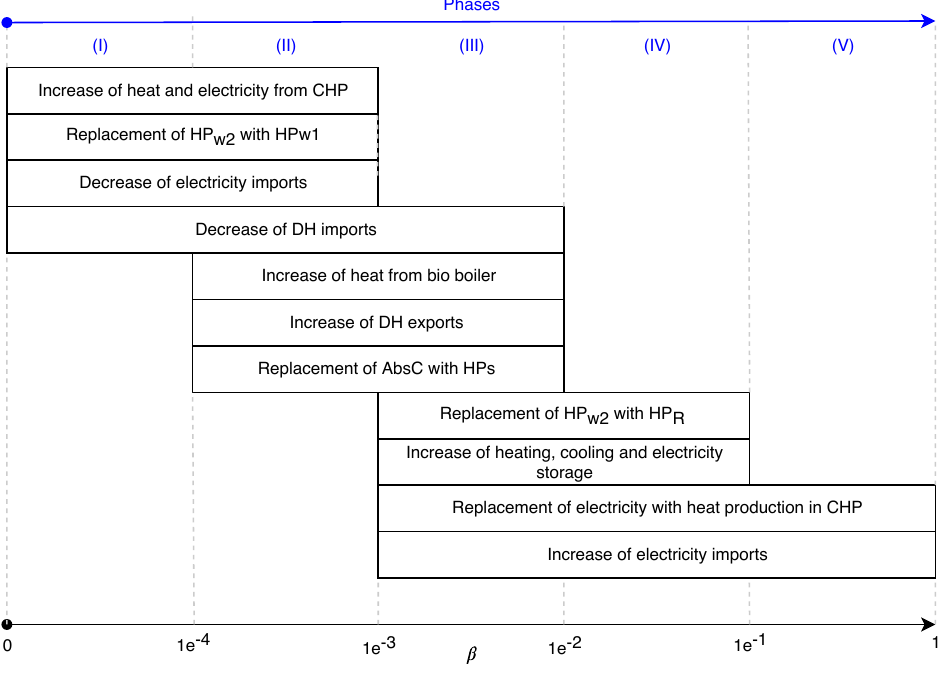
Figure 7. CO 2 abatement strategies at different